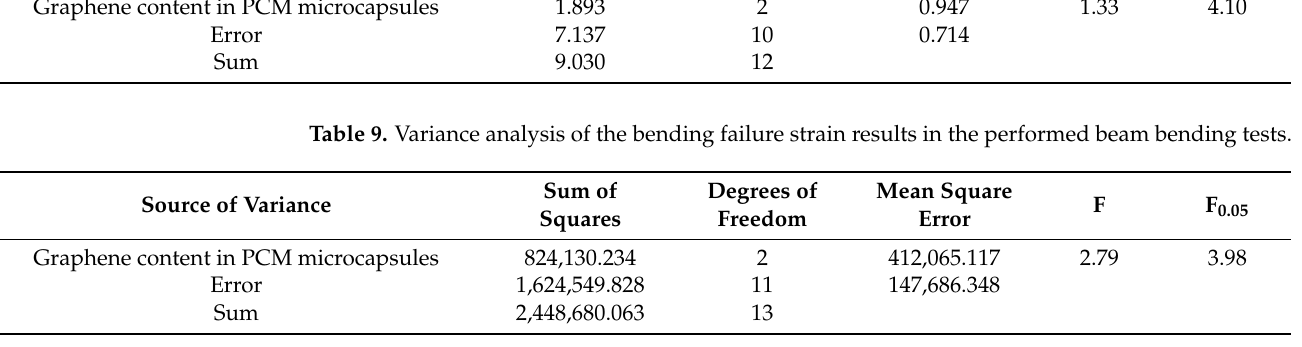
Table 10. Variance analysis of the bending stiffness modulus results in the performed beam